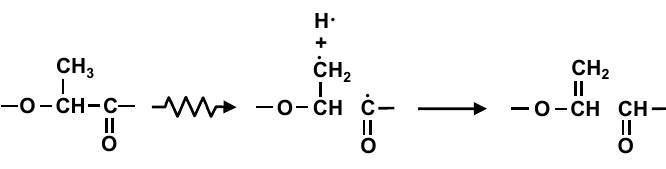
Figure 9. Image of degradation reaction of irradiated PLA ‐ 0.